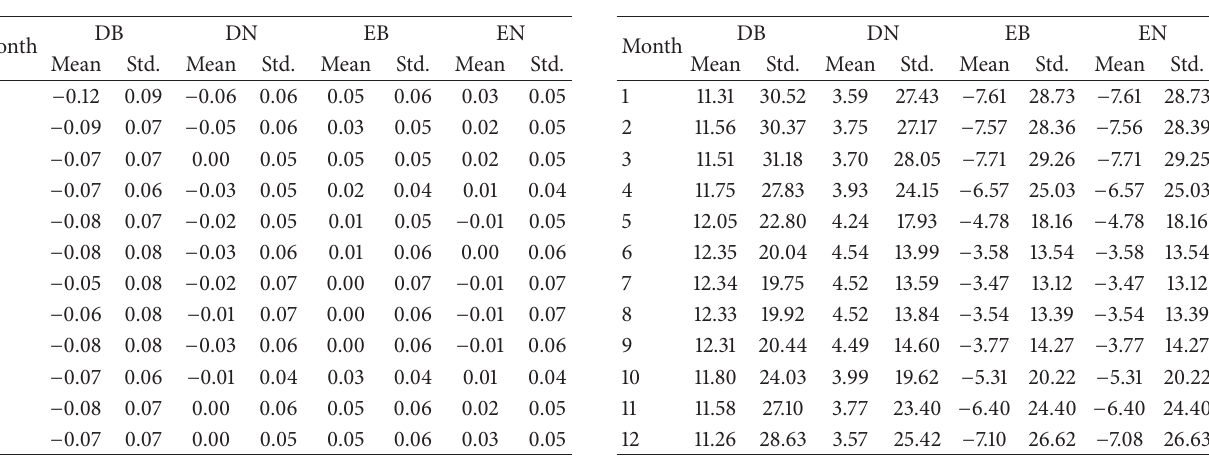
Table 1: Simulated effects of afforestation on the monthly average temperature in Jiangxi Province (measured in degrees Celsius).